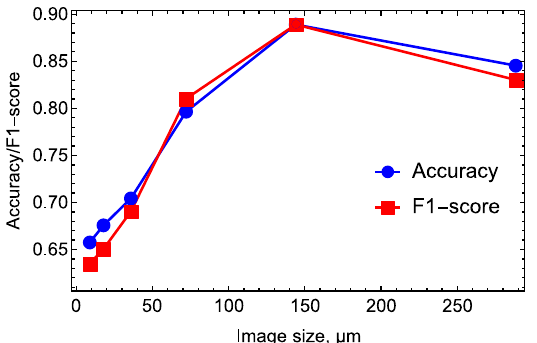
Figure 3. Two quality measures (accuracy and F1-score) shown on the validation set by the VGG13 model trained on images of different sizes. The maximum values are reached at ~144 μ m.